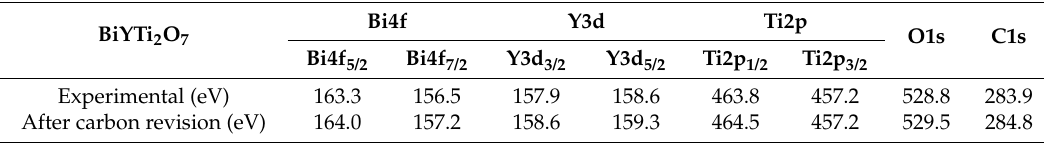
Table 2. Binding energies of key elements in BiYTi 2 O 7 .